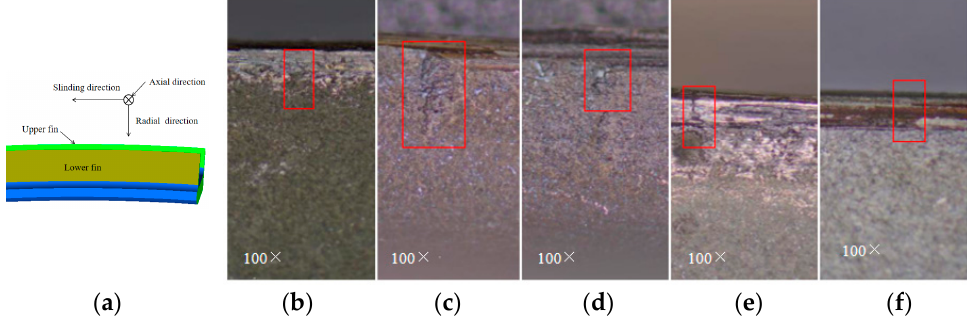
Radial cracks are generated at the junction of the fin tip surface and the side, in zigzag shape, which is different from the crack morphology on the fin tip surface, and the length of the crack along the radial direction is different. Only the cracks in axial radial rubbing mode propagated axially on the fin tip surface, while the cracks in other modes did not propagate axially. The reason is that only one rubbing was carried out, and the thermal stress is not enough to cause the further propagation of the crack. Figure 11. Cracks on the fin tip.